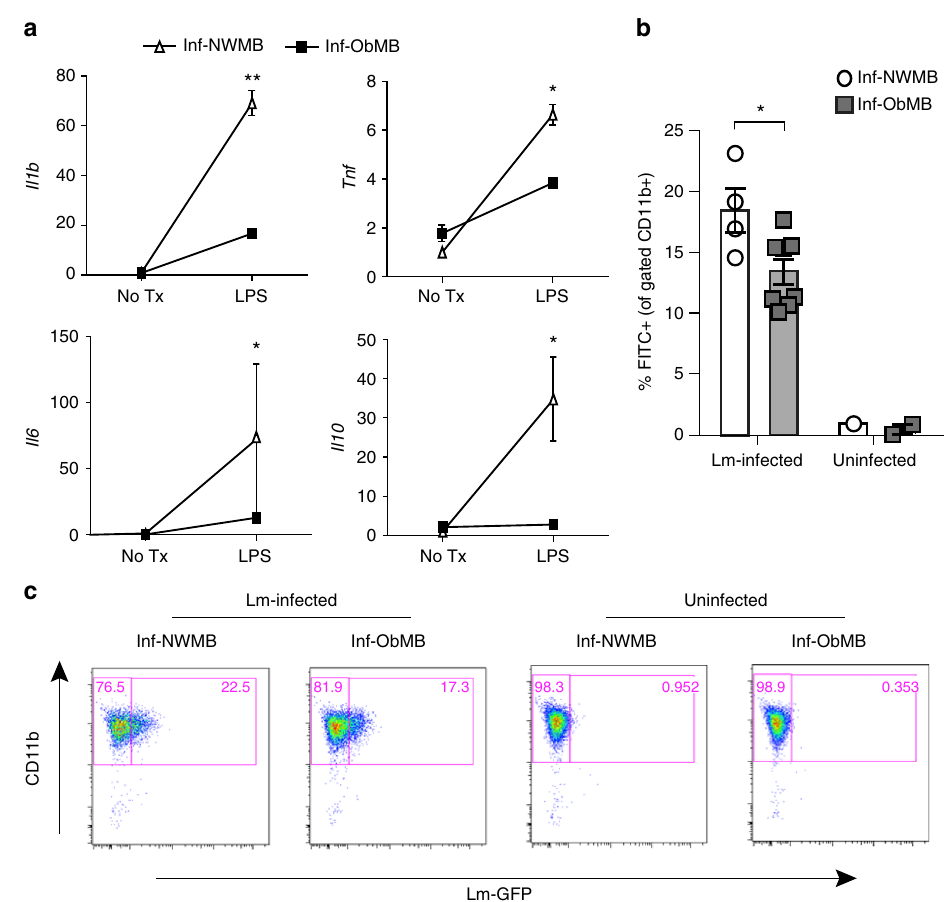
Fig. 5 BMDMs from Inf-ObMB mice have impaired function. a Cytokine relative gene expression in BMDMs with and without 20-h low-dose LPS treatment depicted as relative to the Inf-NWMB no treatment (No Tx) group, with endogenous normalization to Gapdh ; n = 2 for both Inf-NWMB and Inf-ObMB. CD11b + /F4/80 + BMDMs for GFP-expressing Listeria (Lm) uptake ( b ) with representative fl ow diagrams ( c ); n = 4 for Inf-NWMB, n = 8 for Inf-ObMB for Lm-infected; n = 1 for Inf-NWMB, n = 2 for Inf-ObMB for uninfected control. Data are presented as mean ± SEM. * P < 0.05 and ** P < 0.01 by two-tailed Student ’ s t